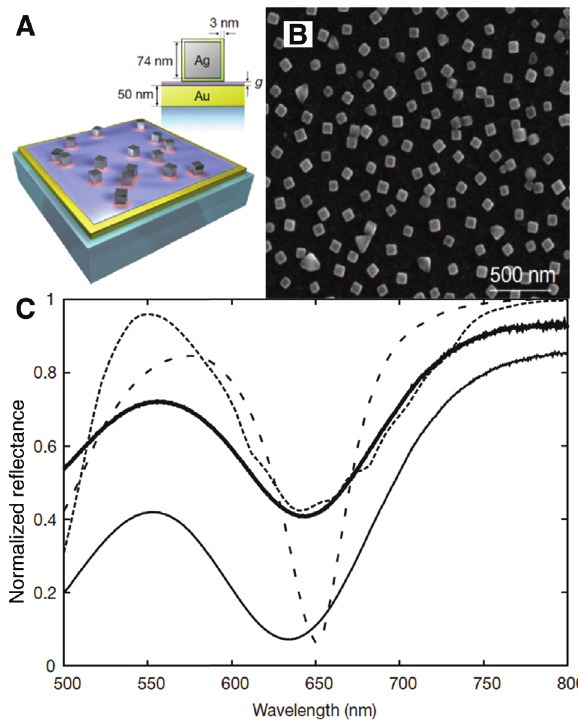
Figure 19: (A) Geometry of the sample studied by Moreau et al. [46]. Tunable reflectance surfaces may be fabricated by covering gold film with Ag nanocubes separated by a 10 nm polymer spacer layer (n = 1.54). (B) Top view SEM image of the fabricated optical metama- terial absorber. (C) Experimental reflectance for normal incidence, normalized to the gold film, for surface coverages of 7.3% (thin solid line) and 17.1% (thick solid line), compared with simulations of uniform cubes (4.2% surface coverage, dotted line) and a model including size dispersion (dashed line, see details included in